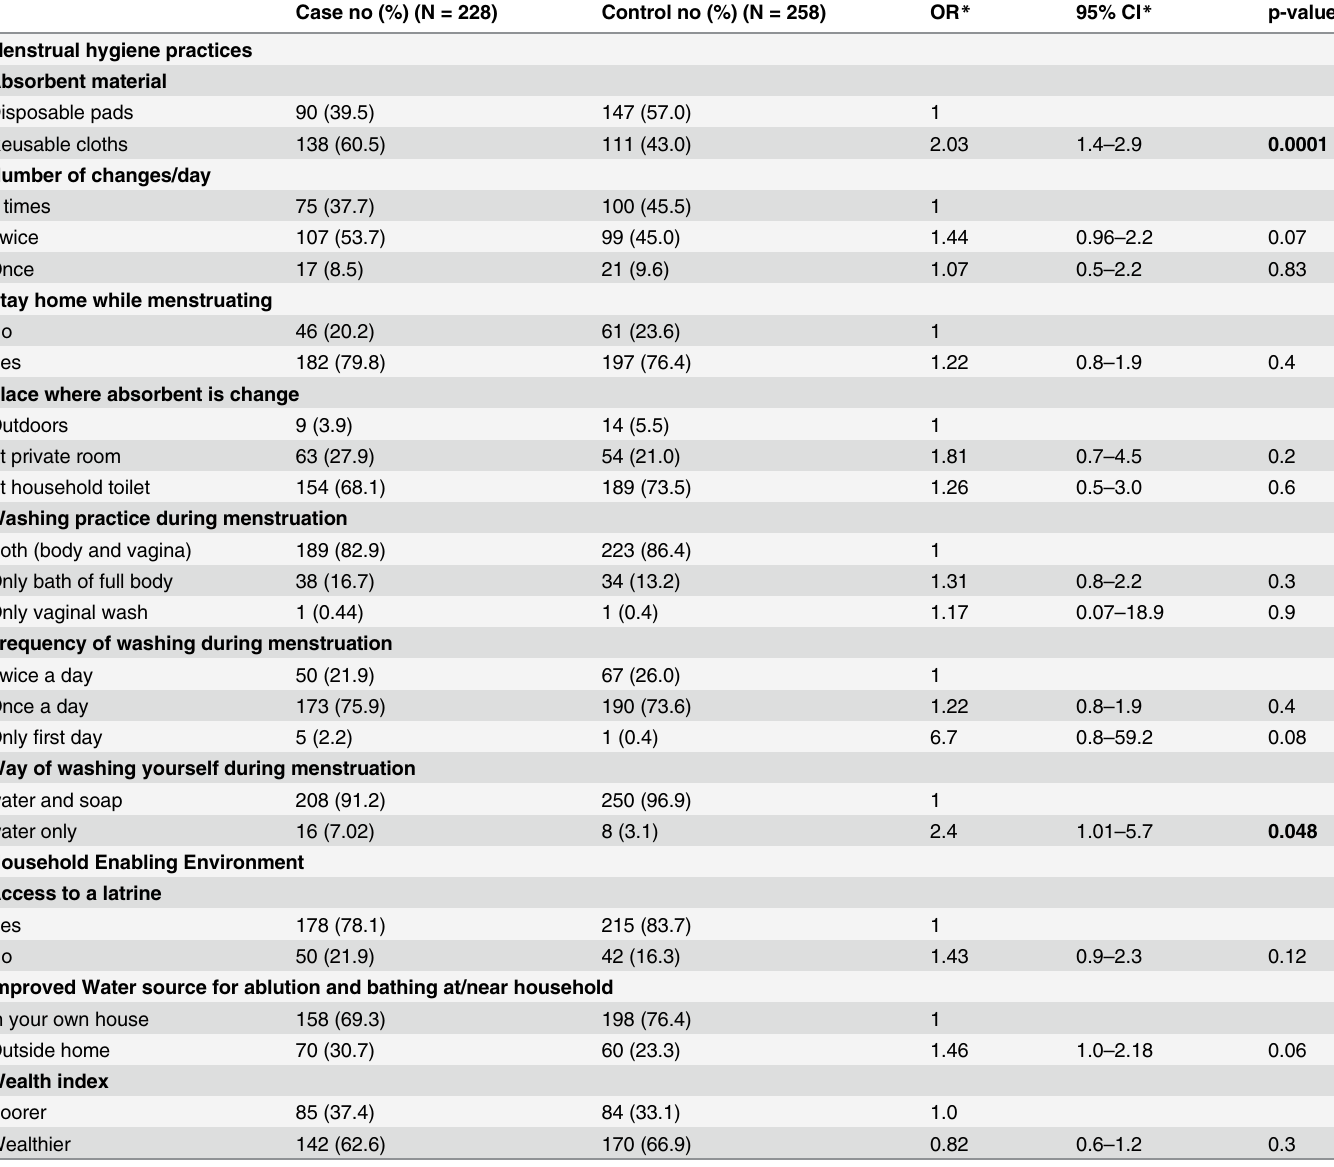
Table 2. Univariate analysis assessing association between different menstrual hygiene management practices and aspects of the household enabling environment for women according to symptomatic status. Case no (%) (N =